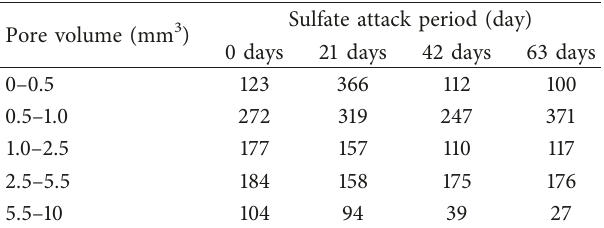
Table 4: Pore distribution of DW-1 exposed to drying-wetting cycles with sulfate